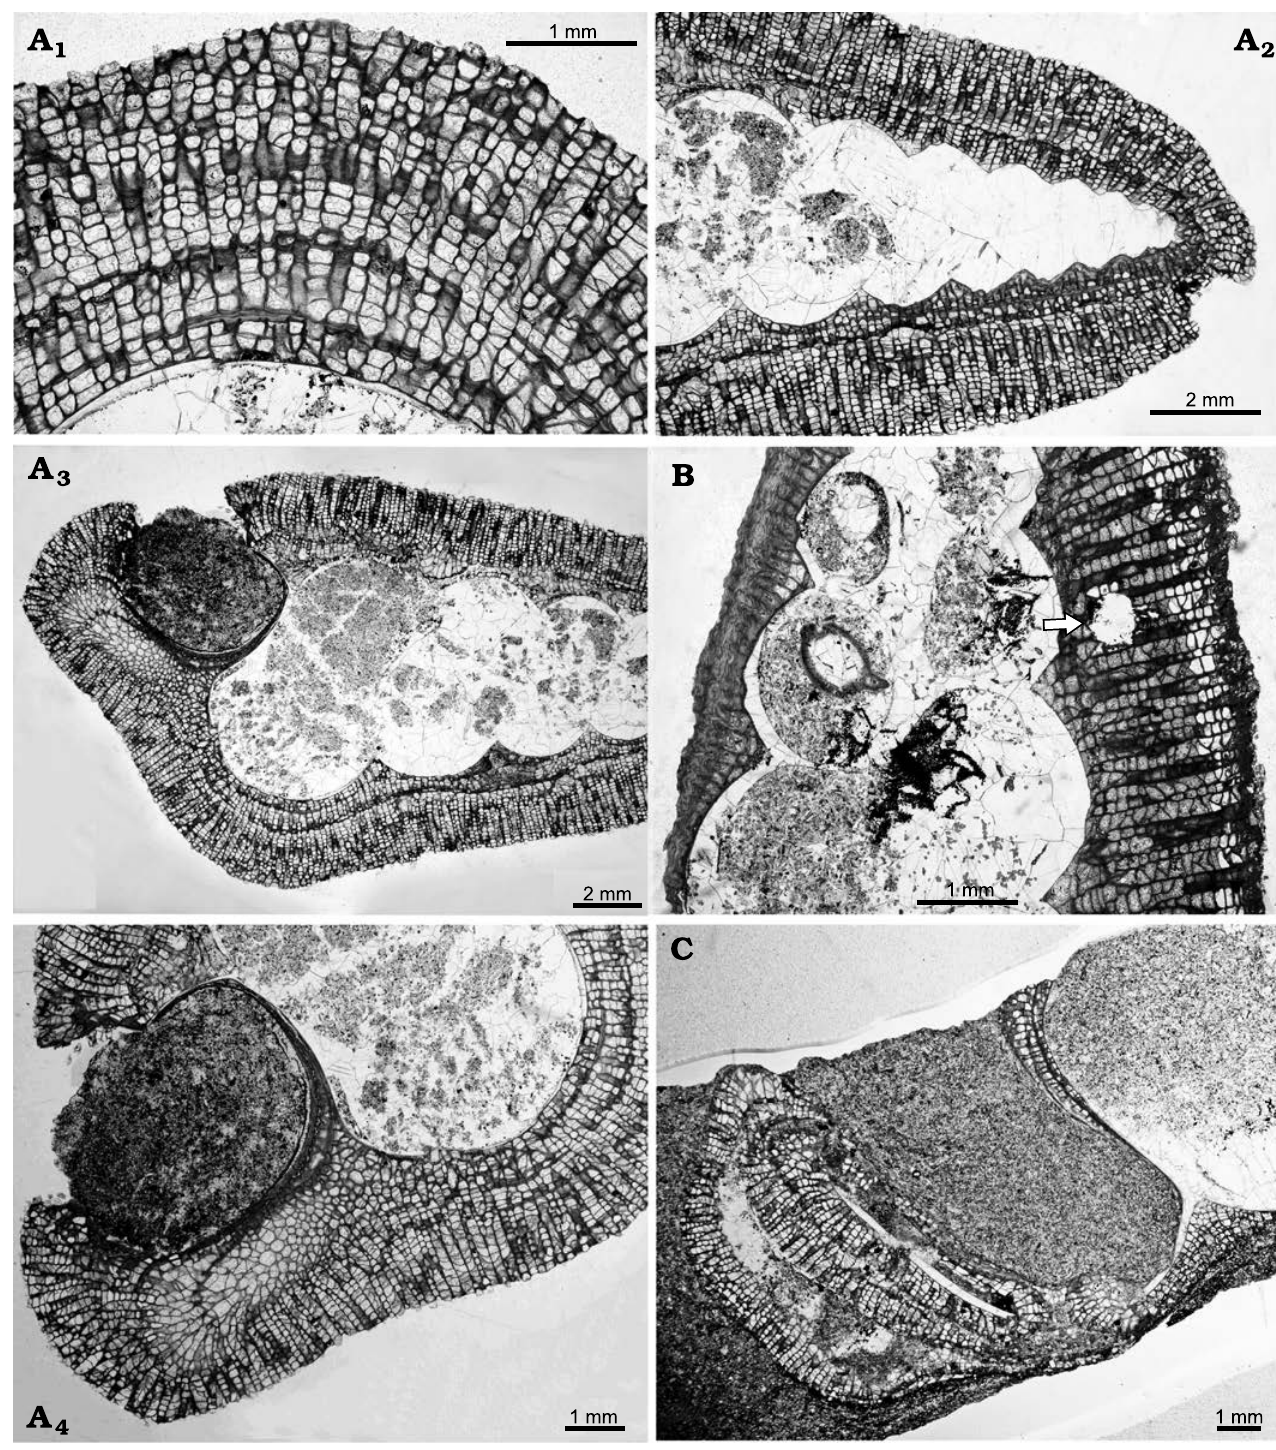
Fig. 3. Thin sections of trepostome bryozoan Homotrypa cochlea sp. nov. from Upper Leintwardine Formation; Ludfordian, upper Ludlow, Silurian; Delbury Quarry, Shropshire, UK. A . NMW 2019.21G.5.2, encrusting colonies comprising multiple layers caused by self-overgrowths (A 1 ), apex of gastropod shell encrusted with bryozoan colony (A 2 ), colony does not grow over the gastropod shell aperture (A 3 , A 4 ). B . NMW 2019.21G.6.2, colony encrusting apertural side of shell thinner than on the abapertural side, arrow indicates Trypanites boring in bryozoan colony. C . NMW 2019.21G.7.3, colony can be seen inside the aperture of gastropod